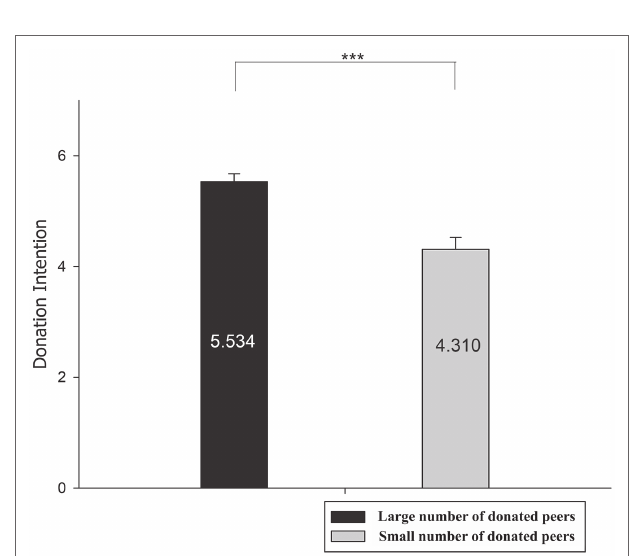
FIGURE 3 | The behavioral results of donation intention. The black bar represents the average donation intention in the large number of donated peers, whereas the grey bar represents the average donation intention in the small number of donated peers. *** p <